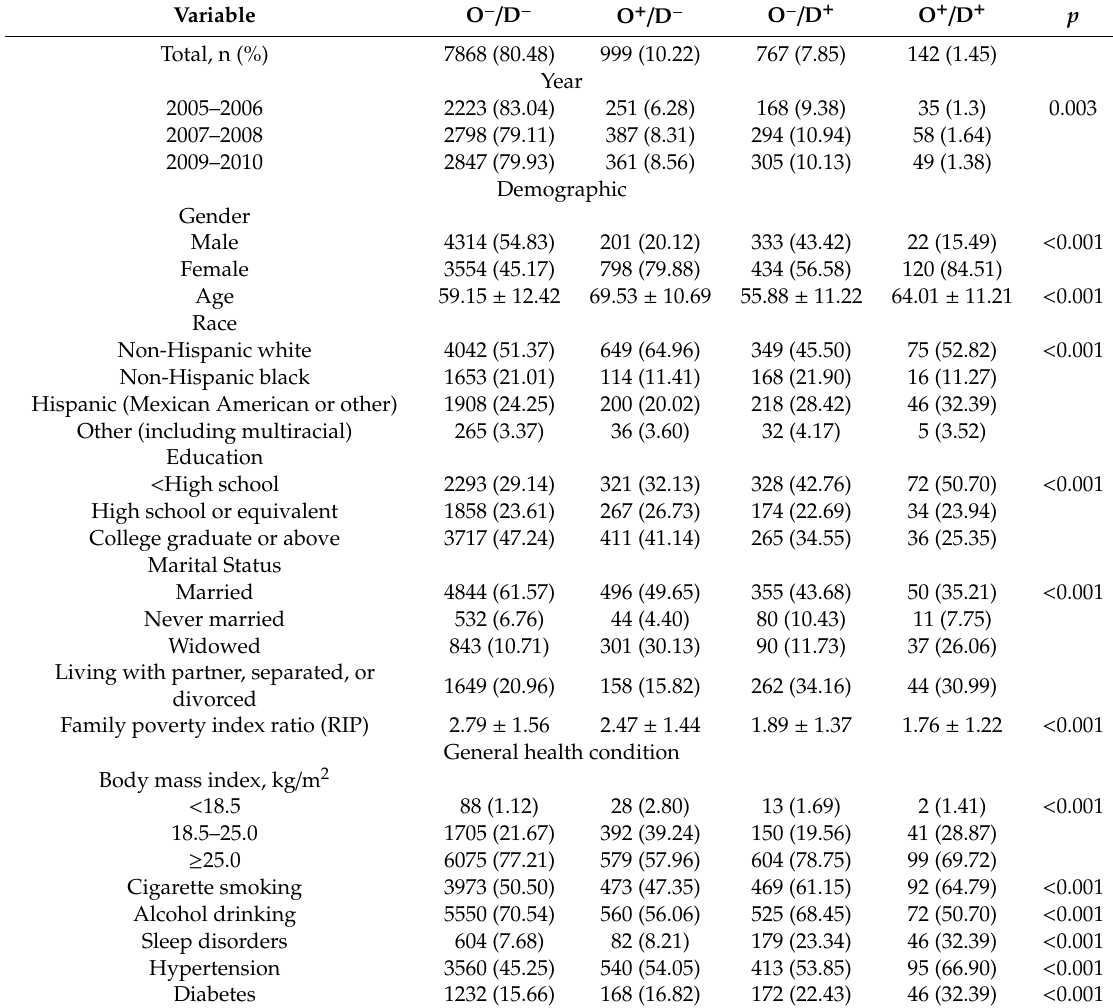
Table 1. Characteristics of four